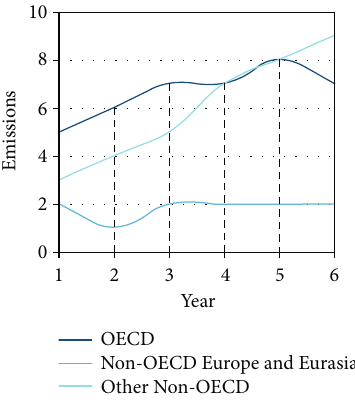
Figure 2: Global renewable energy